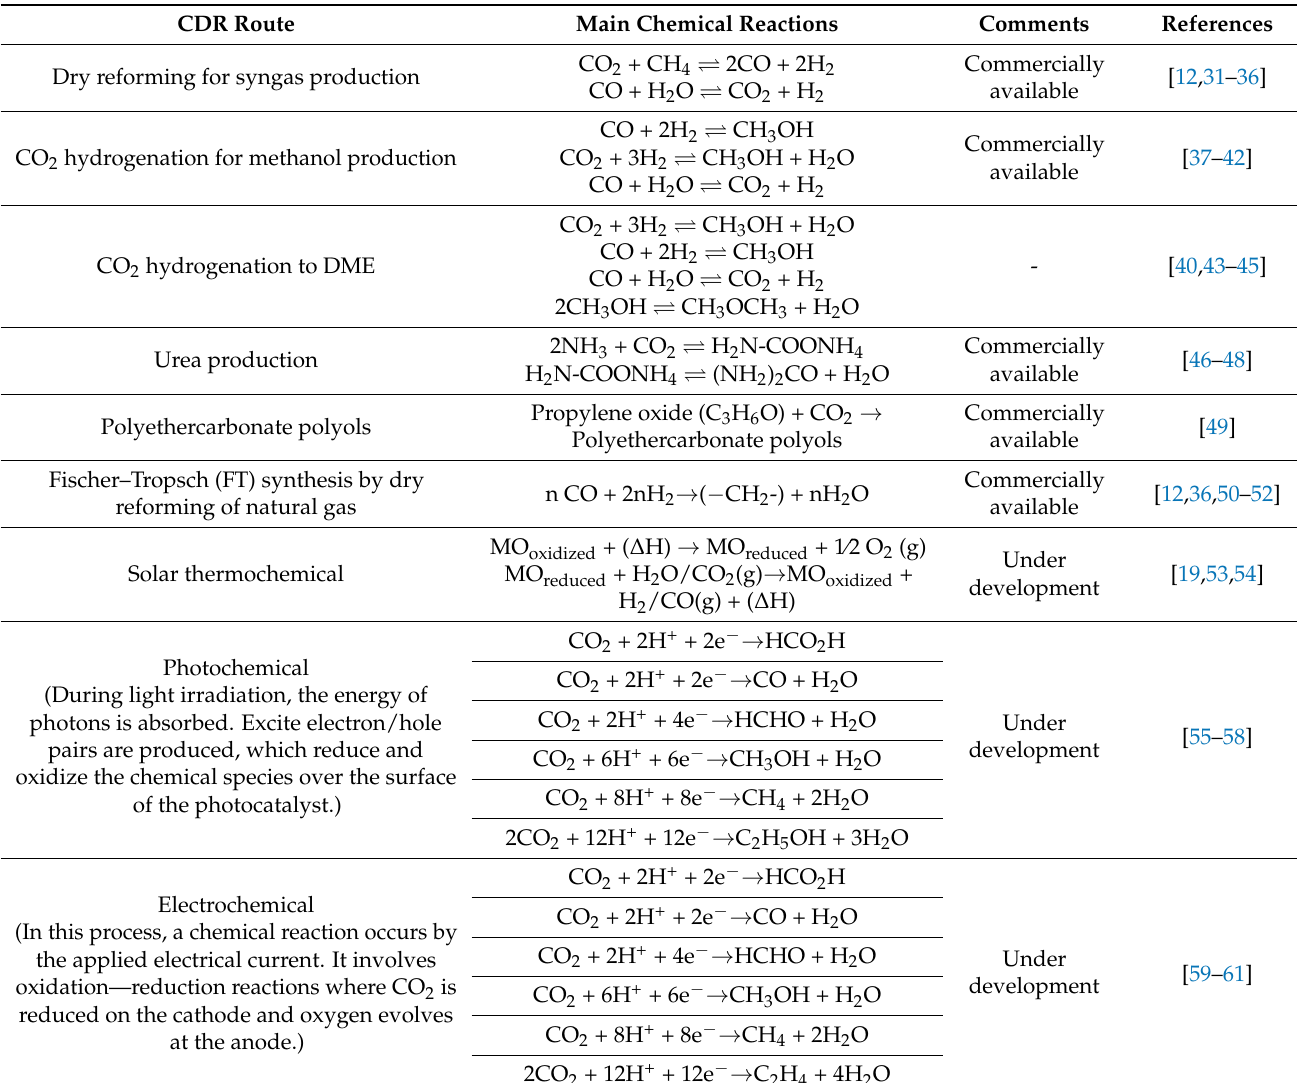
Table 1. The main CDR processes utilize CO 2 as a